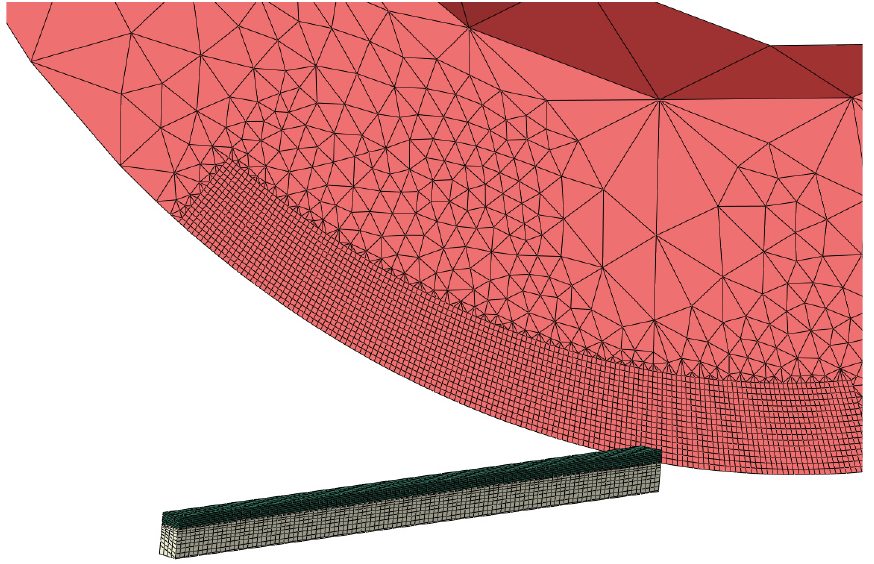
Figure 2. Undeformed mesh for cutting tool and